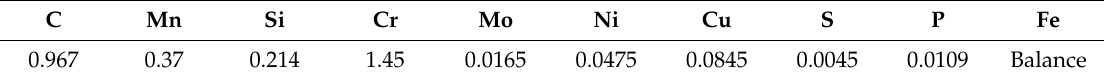
Table 1. Actual chemical composition of GCr15 used during